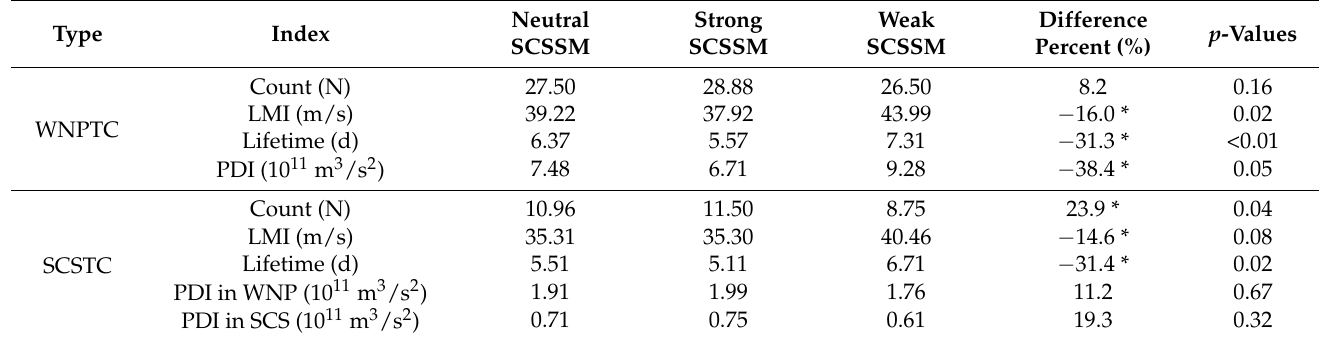
Table 1. Statistical characteristics of indicators for TC activity in SCSSM anomalous